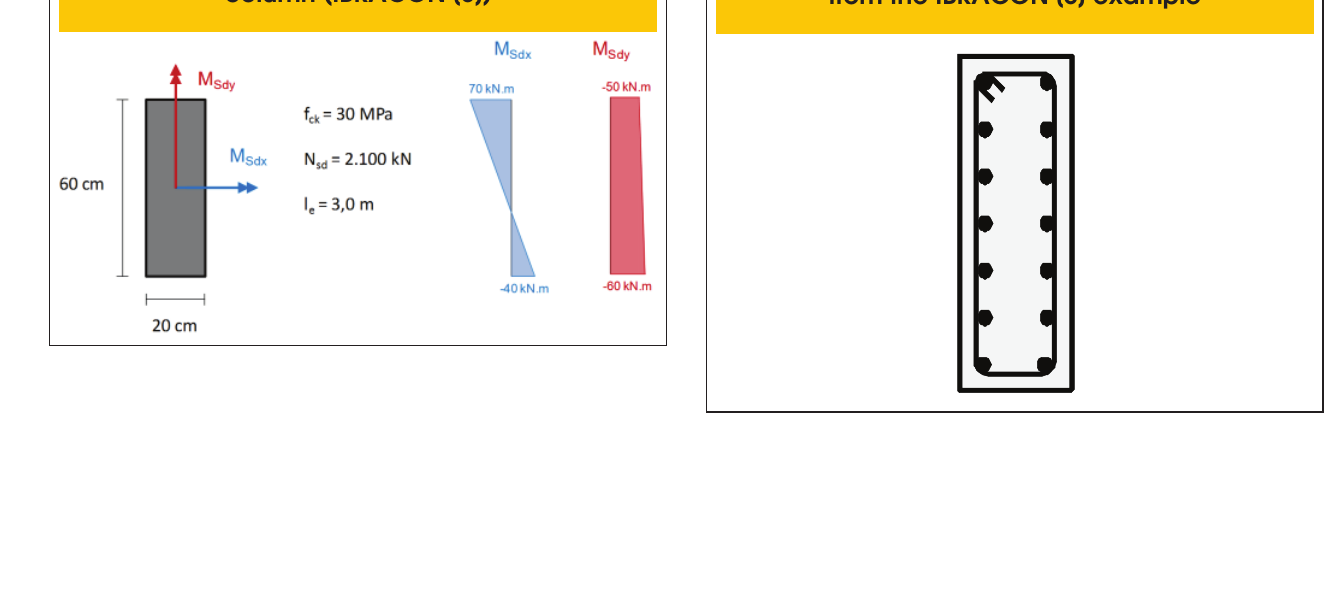
Figure 11 – Data for the example column (IBRACON [6])